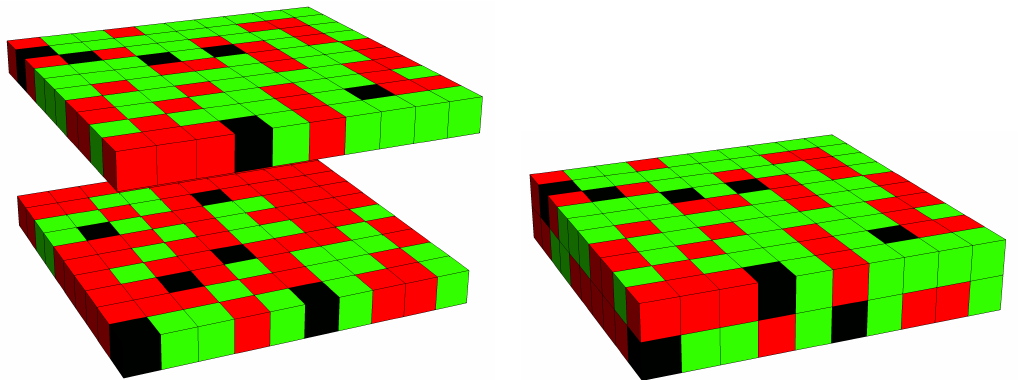
Figure 3. Lattice model for a mixed lipid bilayer that contains “peripheral” proteins. The snapshot shows the two membrane leaflets separated (left diagram) and merged into a bilayer (right diagram). Positions of lipids of type A (green), lipids of type B (red), and peripheral proteins (black) are all uncorrelated across the lattice. While both leaflets may have different lipid compositions, they contain the same number of peripheral proteins. The displayed snapshot corresponds to a square lattice ( z = 4) of size M = 10 × 10 and mole fractions φ = 0.61 (the upper leaflet), ψ = 0.30 (the lower leaflet), and α =